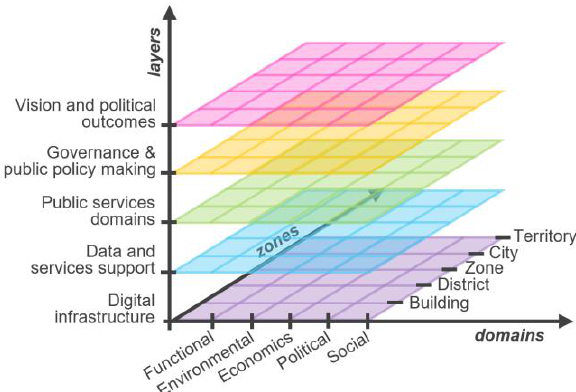
Figure 2. Smart City Model architecture